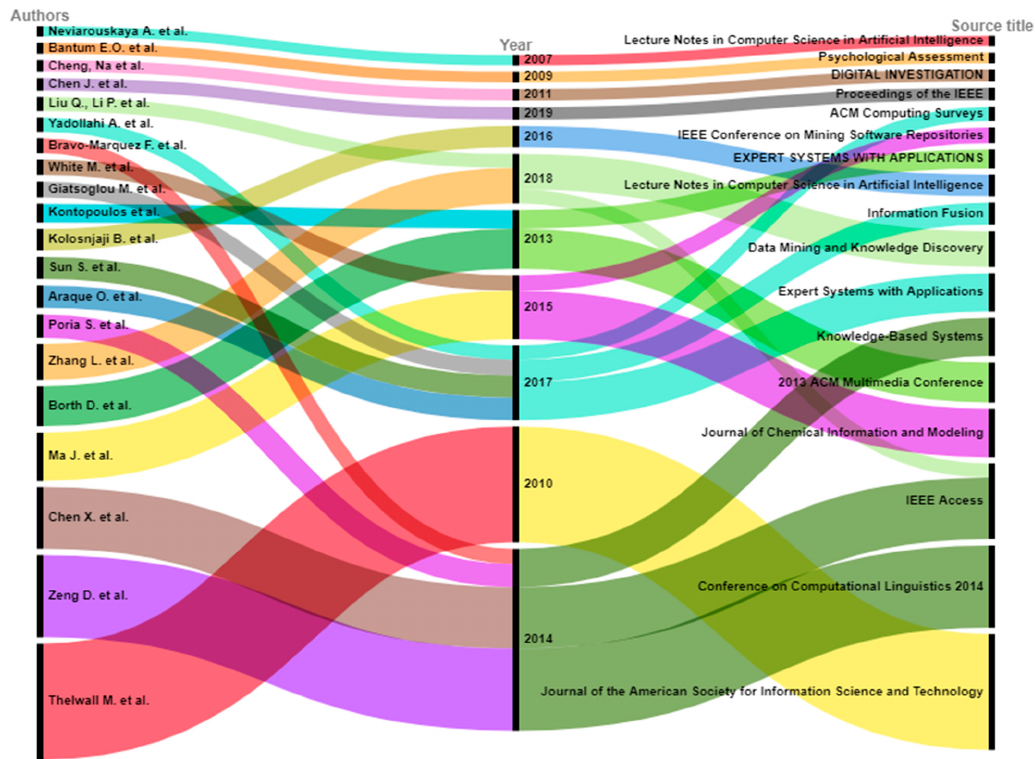
Figure 17. Alluvial diagram of authors, source titles, and year of publication for highly cited publications. Table 16. Number of citations per year from Scopus and Web of Science. The documents with the largest citations are shown in the network diagram. In the network graph, we can observe that the top ten highly cited publications with the authors’ names are visible. The color chart on the bottom side depicts the degree of large correlation with the year of publication. The network analysis of Figure 18 is carried out using VOS Viewer.